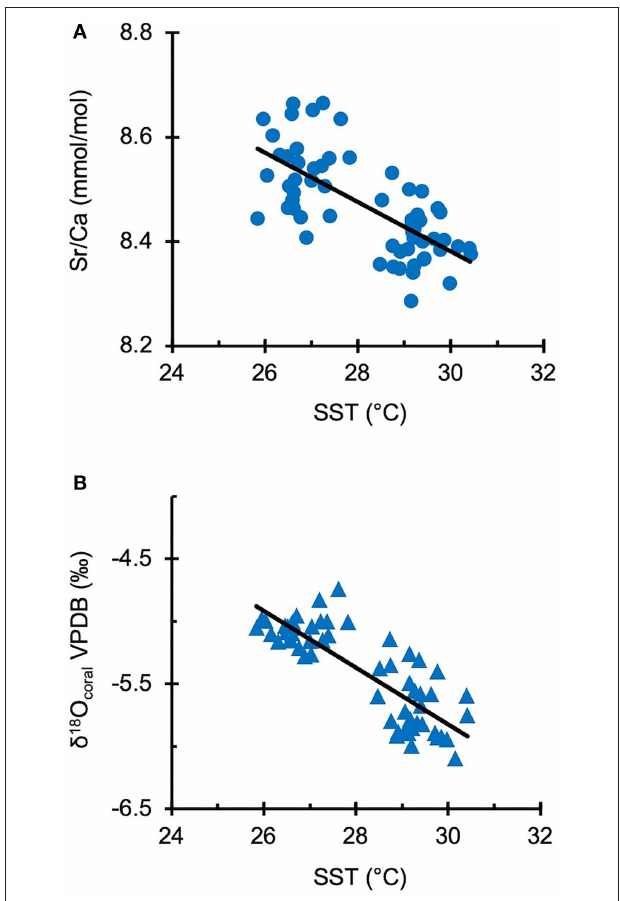
FIGURE 5 | Calibration of coral geochemical tracer vs. IGOSS SST for the period 1982–2012. (A) Calibration of coral Sr/Ca vs. IGOSS SST (Sr/Ca = − 0.047 * SST + 9.799, r 2 = 0.48, p < 0.001). (B) Calibration of δ 18 O coral vs. IGOSS SST ( δ 18 O coral = − 0.227 * SST + 0.971, r 2 = 0.69, p <